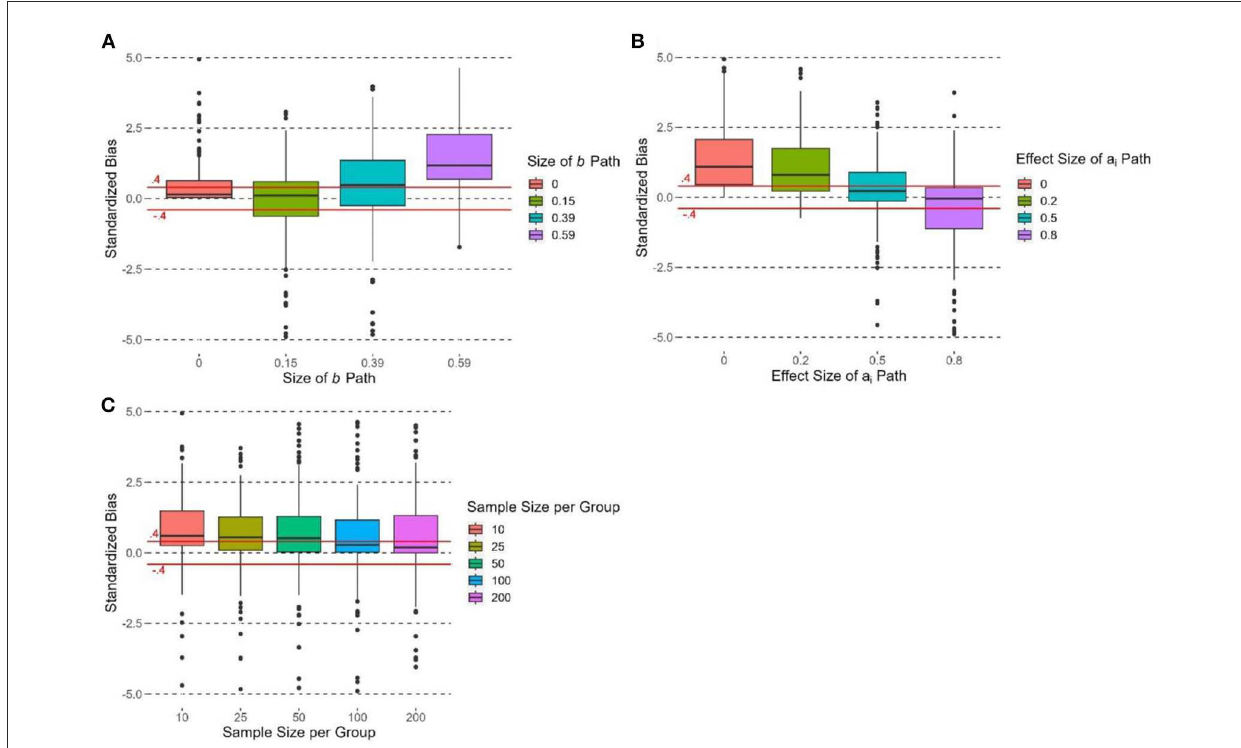
FIGURE4 Boxplots of standardized bias of ˜ υ OPE grouped by (A) size of b path, (B) effect size of a i path, and (C) sample size per group. Due to the limit of y-axis, 6.53% of the observations are not shown in each box plot; the acceptable range of standardized bias (i.e., between − 0.4 and 0.4) is indicated by the solid horizontal lines.